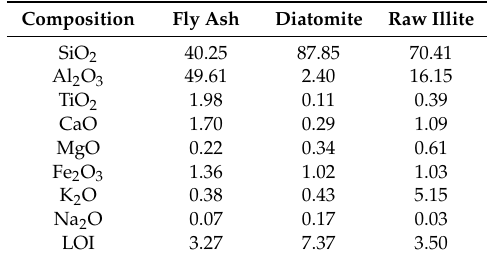
Table 1. Composition of starting materials (mass fraction, %).